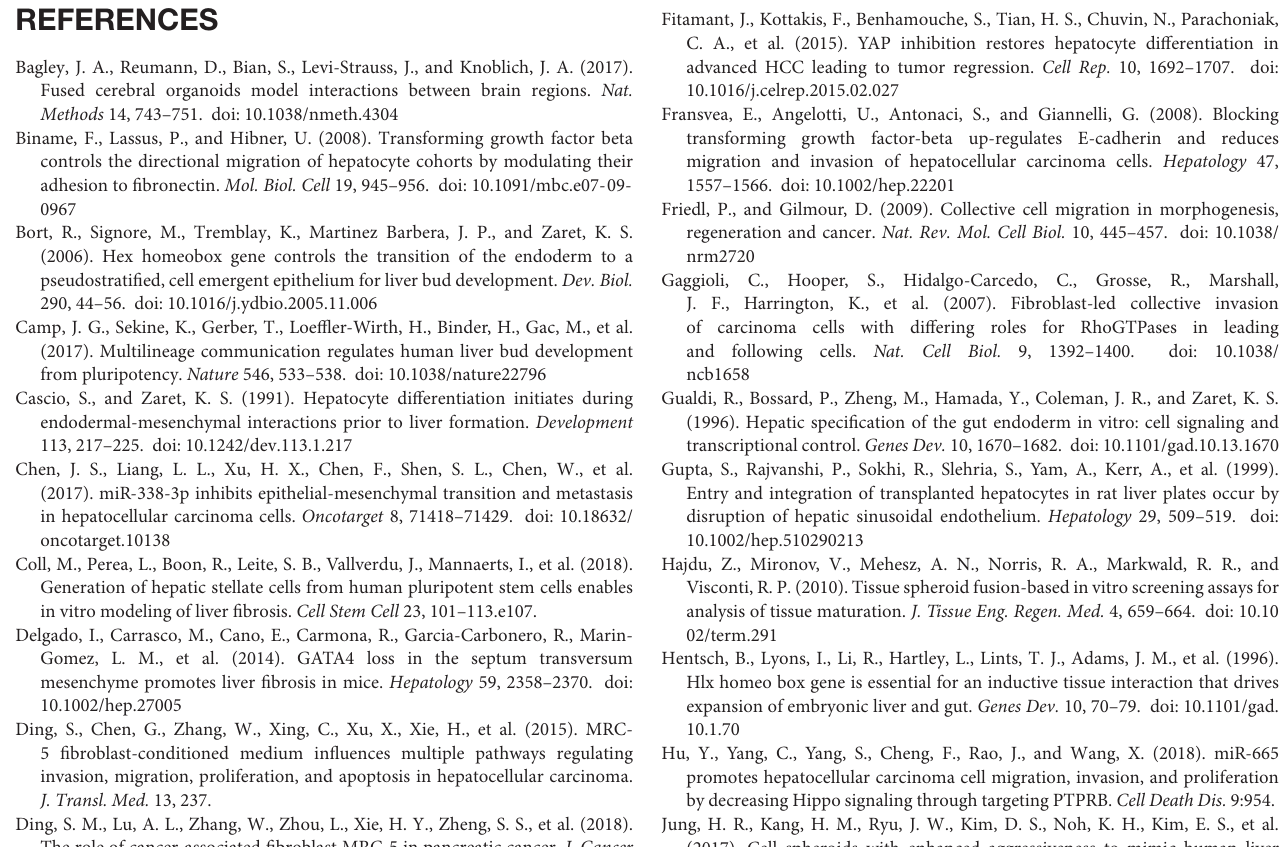
Supplementary Figure 13 | Ki67 staining of HepG2 spheroids in MG droplet culture. HepG2 spheroids formed in suspension culture using a 384-well round-bottom ultra-low attachment plate (3-day culture) were harvested and seeded into MG droplets on tissue culture-treated 60 mm dishes. MG droplets were then cultured in MRC-5-conditioned media (M-CM) for an additional 4 days. On day 7, droplets were fixed with 4% paraformaldehyde (PFA) at room temperature, permeabilized with 1% Triton X-100, and stained using monoclonal primary antibody, Ki67, a marker of proliferation. Spheroids treated with M-CM staining showed positive expression for Ki67 localized to migrating cords as compared with control, droplets cultured in serum- containing DMEM. Supplementary Figure 14 | Phase-contrast images on day 7 of HepG2 spheroid in MG culture treated with various conditioned medium conditions including M-CM (far left), control (DMEM, 10% FBS, 1% Pen-strep, left), HFF-CM (right), and HepG2-CM (far right). In addition, a separate cell line, human embryonic kidney cells, HEK, were made into spheroids, embedded into MG, and cultured in M-CM (days 7 and 11 are shown). Radial migration is apparent in HepG2 and HEK conditions where M-CM media are included. Supplementary Figure 15 | Collagen gel-embedded HepG2 spheroids on day 7 exhibit radial migration. HepG2 spheroids were formed in suspension using a 384-well round-bottom ultra-low attachment plate (3-day culture) were collected and seeded into collagen droplets on tissue culture-treated 60 mm dishes. Collagen droplets were then cultured in MRC-5-conditioned media (M-CM) for an additional 4 days. On day 7, migrating spheroids were observed and shown to exhibit thin radial protrusions into the matrix that was consistent among eight individual